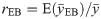
For the simulated population, bias index of the El-Badry estimator as a function of the nonresponse rate at the last phase.Curve of the bias index rEB=E(y¯EB)/y¯ based on 10 000 simulations of the nonresponse mechanism, for L = 2(1)6, πz = 0.2, πm(i) = 0.85 for 1 ≤ i < L, and πm(L) = 0(0.1)0.9 (black dots
L = 2; white circles
L = 3; black triangles down
L = 4; white triangles up
L = 5; black squares
L = 6). Details in the text.